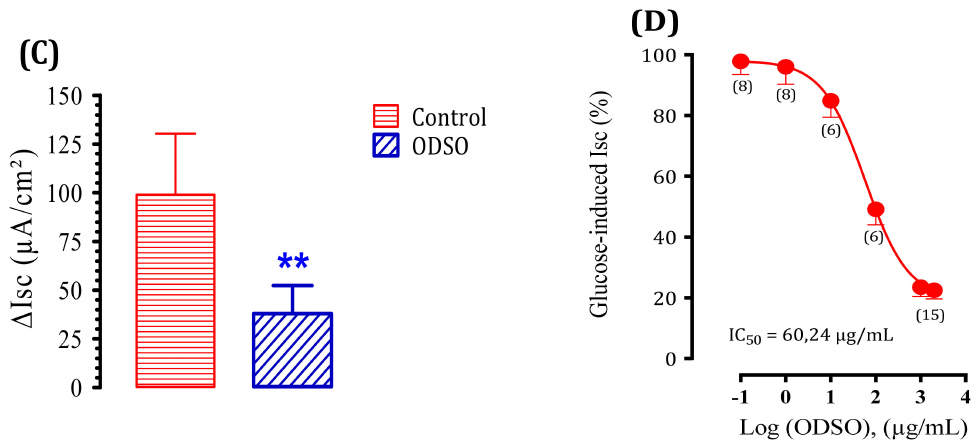
Figure 5. Effect of ODSO on the glucose-induced short-circuit current (Isc). ( A ) Typical recording of the inhibition of Isc ( µ A/cm 2 ) across the mouse jejunum segment isolated in the Ussing chamber by phlorizin (PHZ) added on the mucosal side 10 min before the luminal D -glucose challenge (30 mM). This figure showed that PHZ induced the total inhibition of Isc. ( B ) ODSO (1 mg/mL) diluted in a Ringer solution was added on the mucosal side 10 min before the luminal D -glucose challenge (30 mM). An increase in Isc reflects glucose-related electrogenic sodium absorption through (Na+)-glucose cotransporter-1, SGLT1. The maximal increase in Isc was measured at the plateau. ( C ) The AUC of the vehicle and ODSO effects on D -glucose induced Isc. ( D ) The concentration-response inhibition of glucose-induced Isc is expressed as a % of the maximum effect induced by 0.5 mM of phlorizin (PHZ); n = 6–15 ** p < 0.001 tissues studied.